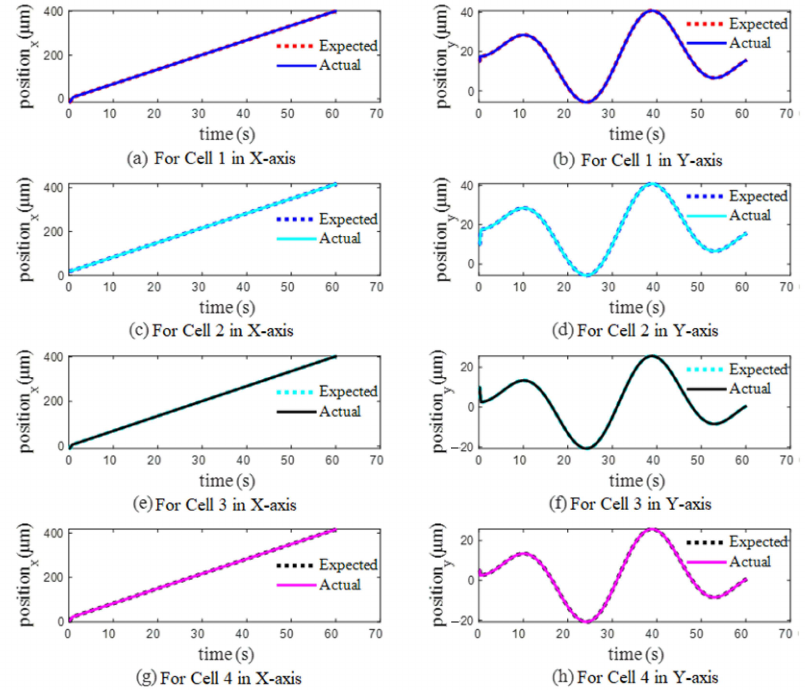
Figure 12. Comparison between the actual trajectories and the expected trajectories of four con- trolled cells.